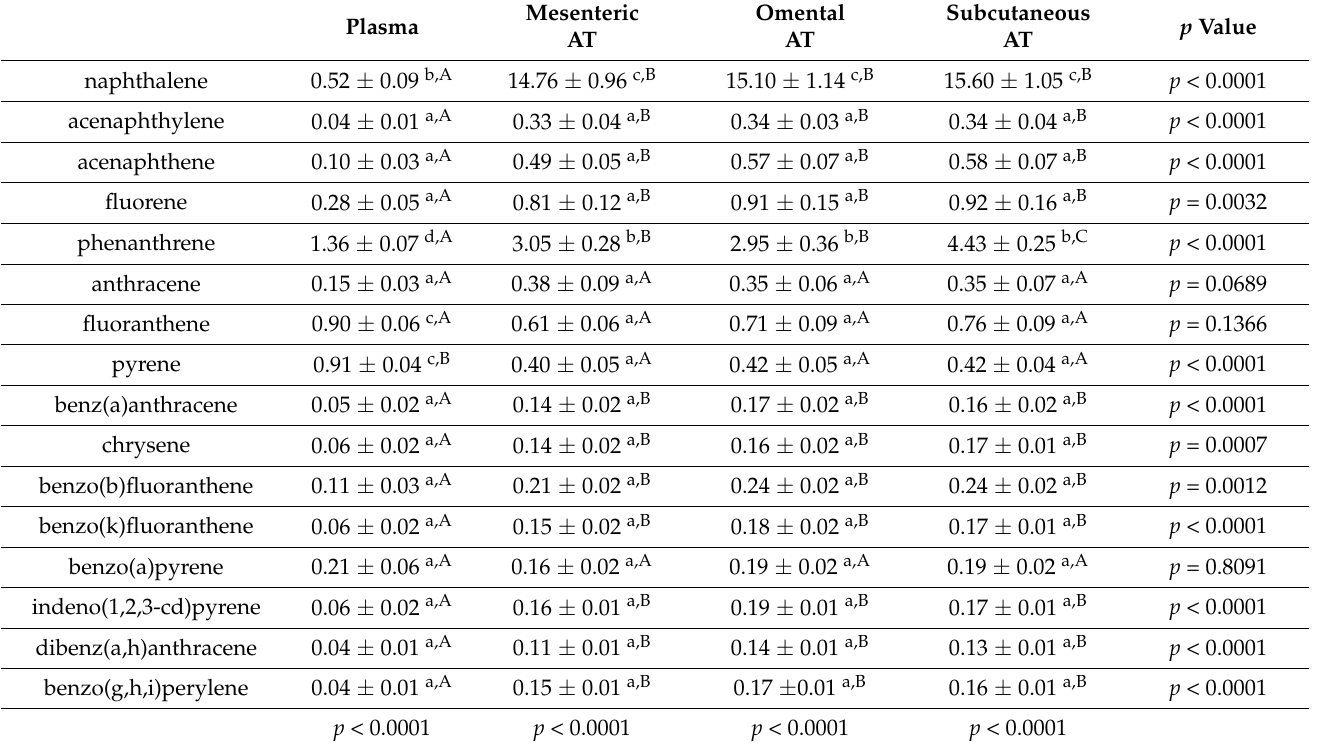
Table 2. Comparison of PAH concentrations between plasma (ng/mL) and three white ATs (mesen- teric, omental, and subcutaneous; ng/g) in French patients ( n = 10). Data are given as mean ± SEM, p ≤ 0.05. Different capital letters indicate a significant effect between different ATs and blood plasma whereas lower case letters indicate a significant effect between the 16 PAHs. Plasma AT AT